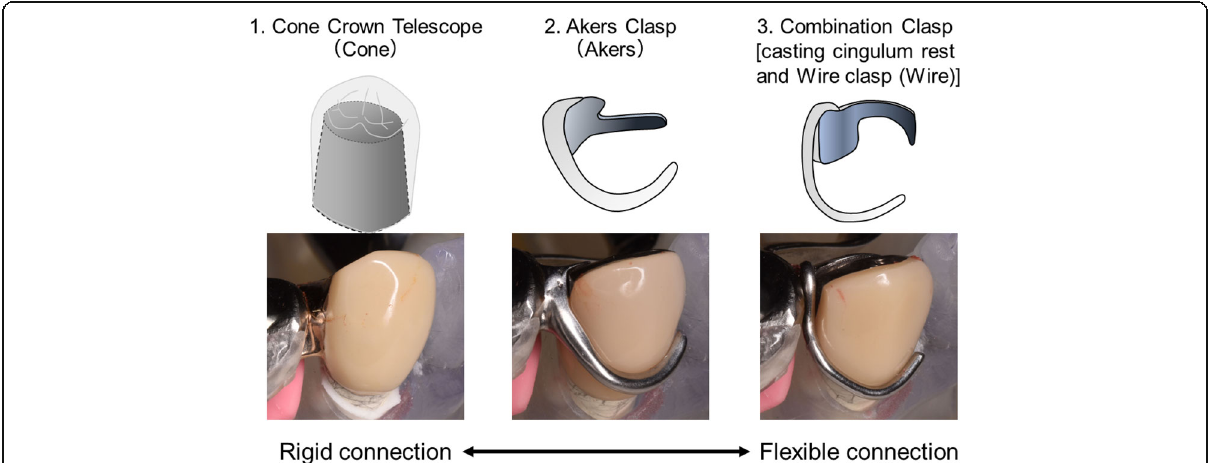
Fig. 3 Schematic illustration of the three different types of direct retainers used to evaluate rigidity